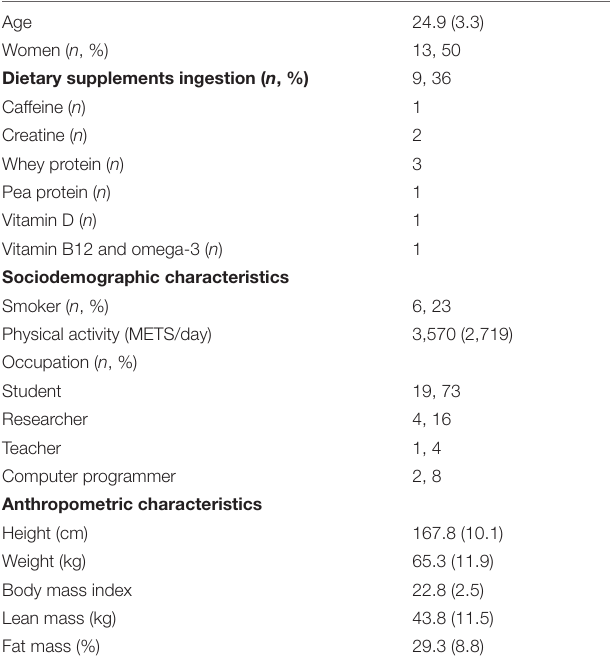
TABLE 1 | Descriptive characteristics of the study participants ( N =